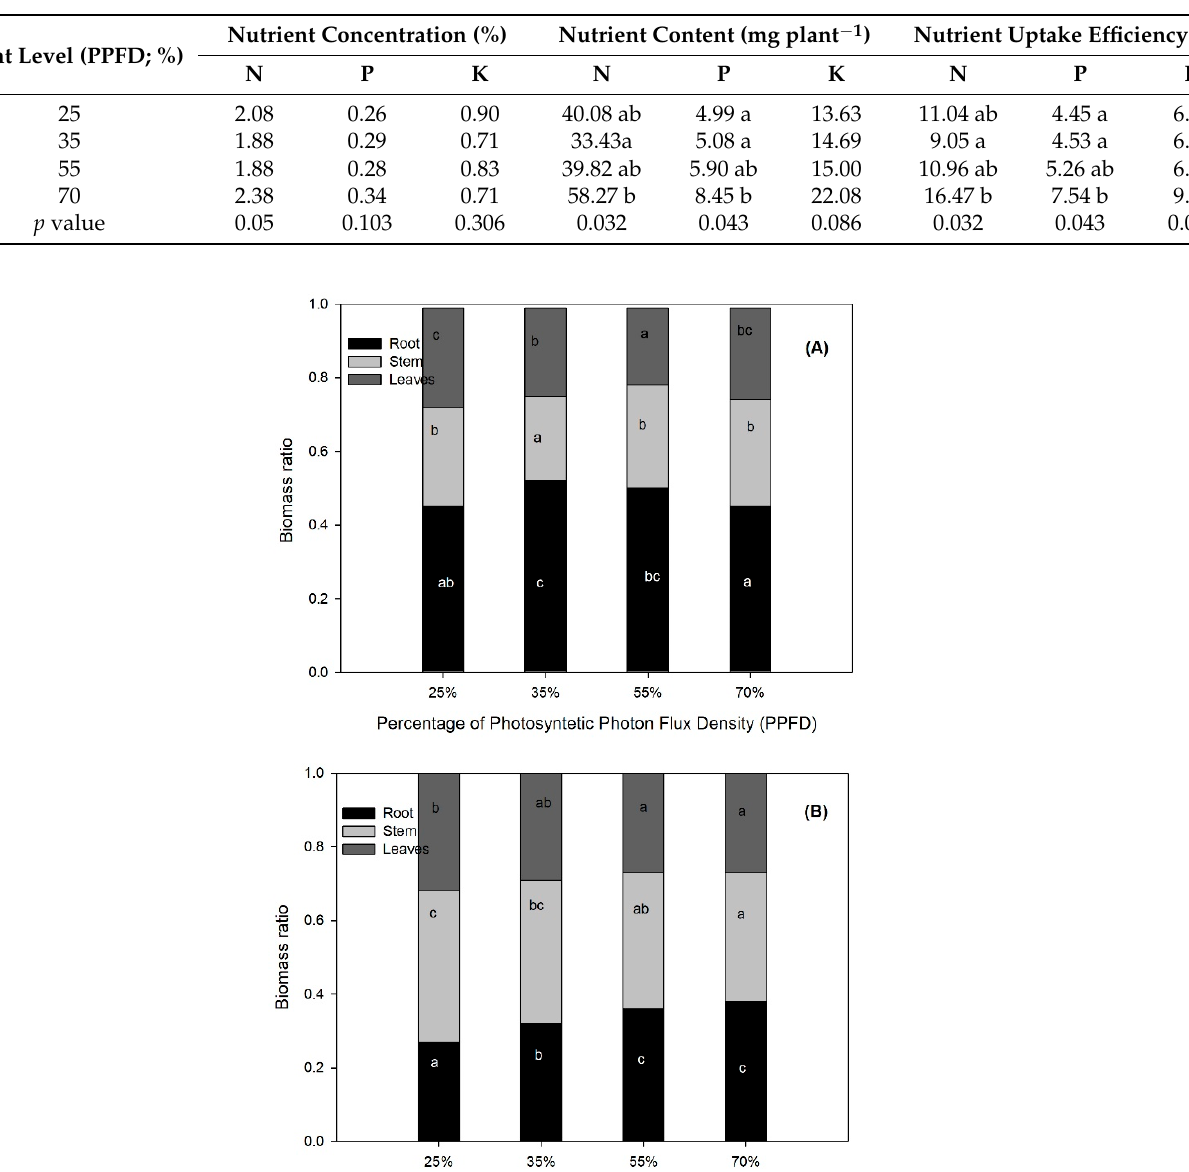
Table 2. Statistical significance and mean values ( n = 4) of variables related to nutrient status of Crescentia alata plants exposed to varying photosynthetic photon flux density (PPFD) levels. For a particular nutrient in the same variable, means with a letter in common are not significantly different ( p > 0.05) according to Fisher’s LSD test ( α = 0.05).